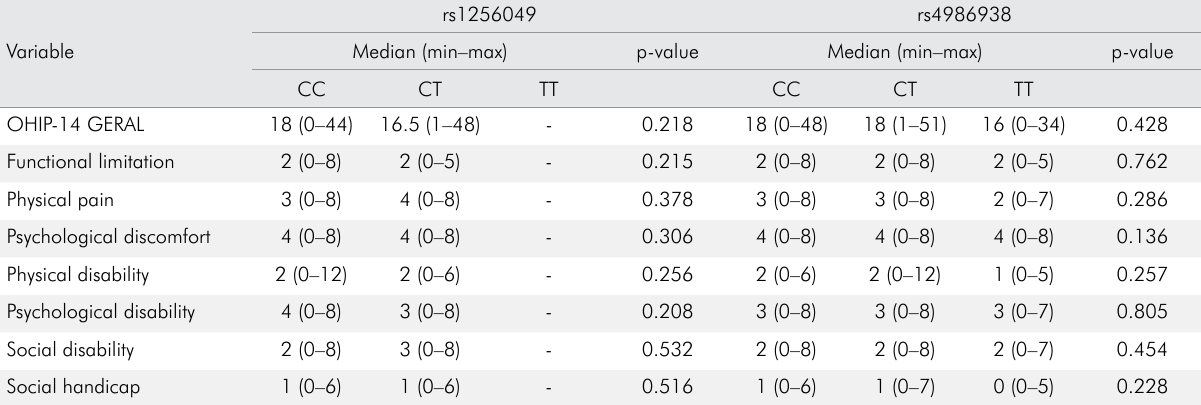
Table 4. Association between OHIP-14 and genetic polymorphisms in estrogen receptor 2 ( ESR2 ) .